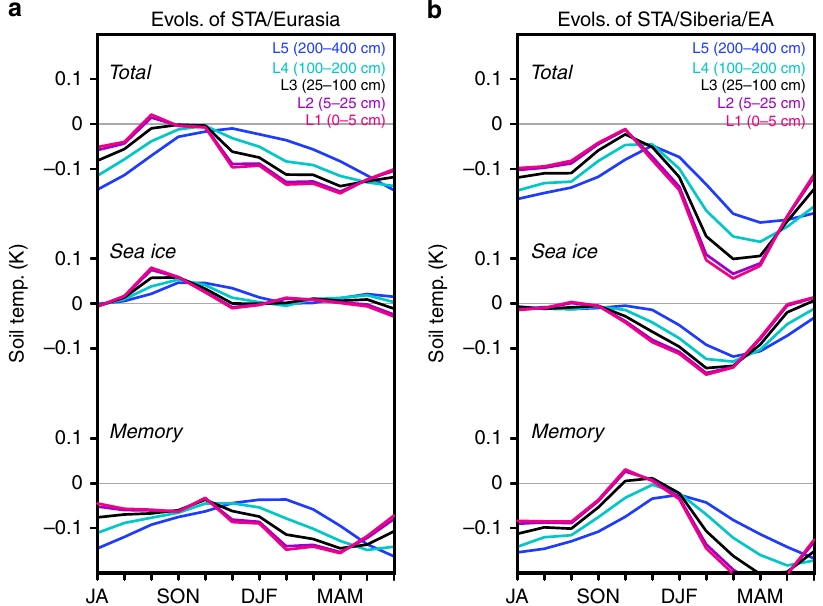
Fig. 6 Annual cycle of the soil temperature anomalies in the model ’ s soil layers. Seasonal evolutions of soil temperature anomalies (STA) in the fi ve individual soil layers (L1 – L5) averaged over a mid-latitude Eurasia (30 – 140°E, 40 – 60°N) and b Siberia/East Asia (90 – 120°E, 40 – 60°N), respectively. From top to the bottom, anomalies of total, sea ice, and memory effects are